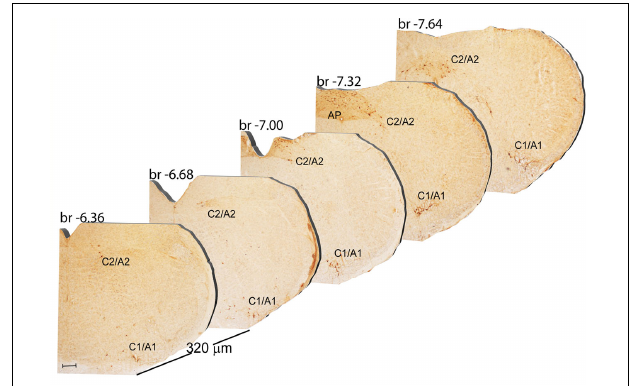
FIGURE 9 | Rostro-caudal reconstruction of the C1/A1 C2/A2 and AP catecholaminergic nuclei. TH immunostaining in 20 µ m coronal mouse brain sections regularly collected every 320 µ m from –6.36 to –7.64 Bregma levels. The figure shows a 3D-like antero-posterior reconstruction of the C1/A1 C2/A2 and AP catecholaminergic nuclei. Scale bar: 200 µ